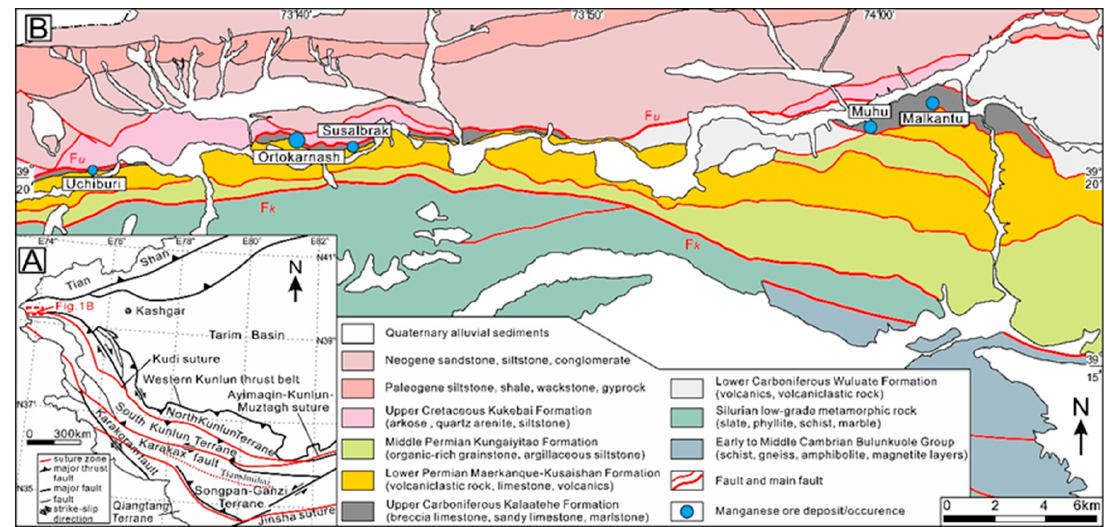
Figure 1. ( A ) Simplified tectonic units of the West Kunlun orogenic belt (modified after [ 44 ]). ( B ) Simplified geological map of the giant Malkansu manganese carbonate zone, northwestern portion of the West Kunlun orogenic belt (modified after [44]).